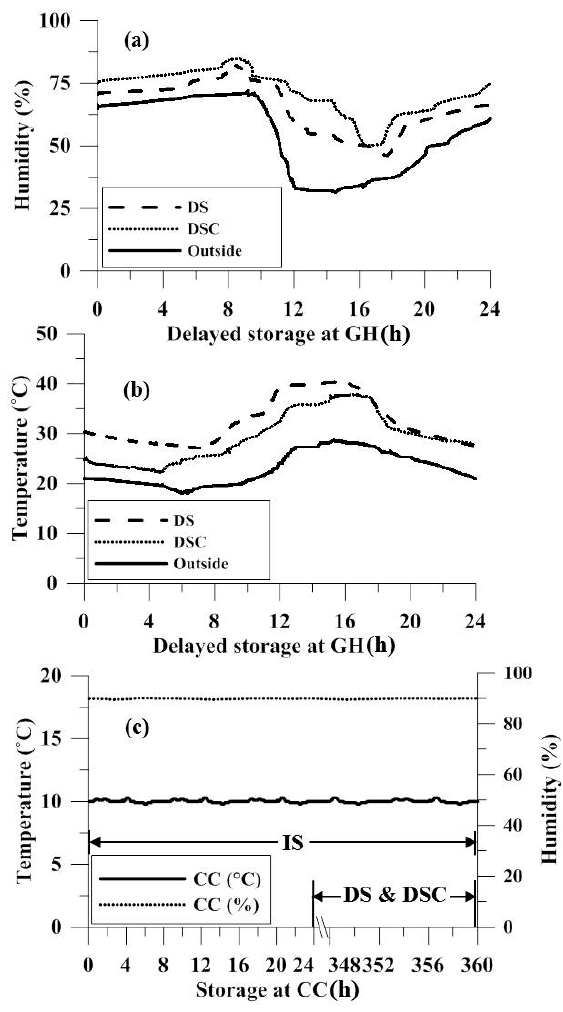
Figure 1. Temperature and humidity status for the delayed storage (DS) and delayed storage under cover (DSC)-treated tomatoes ( a , b ) during 24 h delayed cooling in the greenhouse (GH) and inside the controlled chamber (CC) for immediate storage (IS), DS, and DSC-treated tomatoes ( c ).